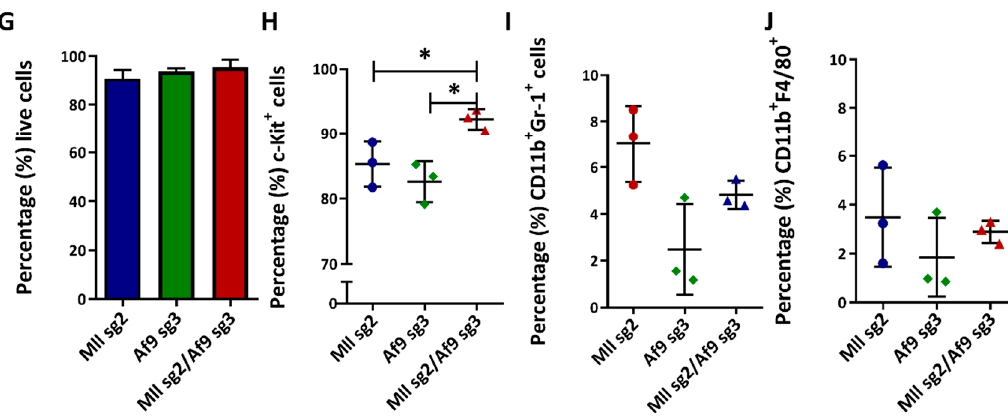
Figure 3. CRISPR-mediated MA9 translocation recapitulates features of MA9 leukaemia: ( A ) Cumulative cell number and growth curve of 32D HSPCs transduced with either Mll sg2 or Af9 sg3 or combination. Cells did not show any significant di ff erence in proliferation following MA9 translocation. ( B ) Cell number and growth curve of 32D HSPCs transduced with Mll and / or Af9 guides as indicated with IL-3 starvation: MA9-translocated cells displayed reduced levels of IL-3 dependency compared to single-guide controls. ( C ) Expression of MA9 target genes: ∆∆ CT values of the sg2 / sg3 sample are normalised to Mll sg2 single guide control. The graph shows mean ± SD of representative experiments. All samples were analysed in technical duplicates. Statistical significance was calculated by one-way ANOVA followed by Bonferroni posttest. p < 0.001 is represented as ***, and p < 0.05 is represented as *. ( D ) Representative colony pictures (400 × ) of CFC colonies after ten days in culture (left panel): Samples were plated in technical triplicates. ( E ) Mean ± SD of colony counts (left) and cell numbers (right). ( F ) Representative flow cytometric plots from samples in Figure 3D with the percentage of relevant populations indicated numerically. ( G – J ) Percentage of each population in samples shown as ( G ) live (DAPI - ), ( H ) c-Kit + , ( I ) CD11b + Gr-1 + and ( J ) CD11b + F4 / 80 + . Each sample is shown as mean ± SD from three technical triplicates. Statistical significance was calculated by one-way ANOVA followed by Bonferroni posttest. p < 0.001 is represented as ***, p < 0.01 is represented as ** and p < 0.05 is represented as